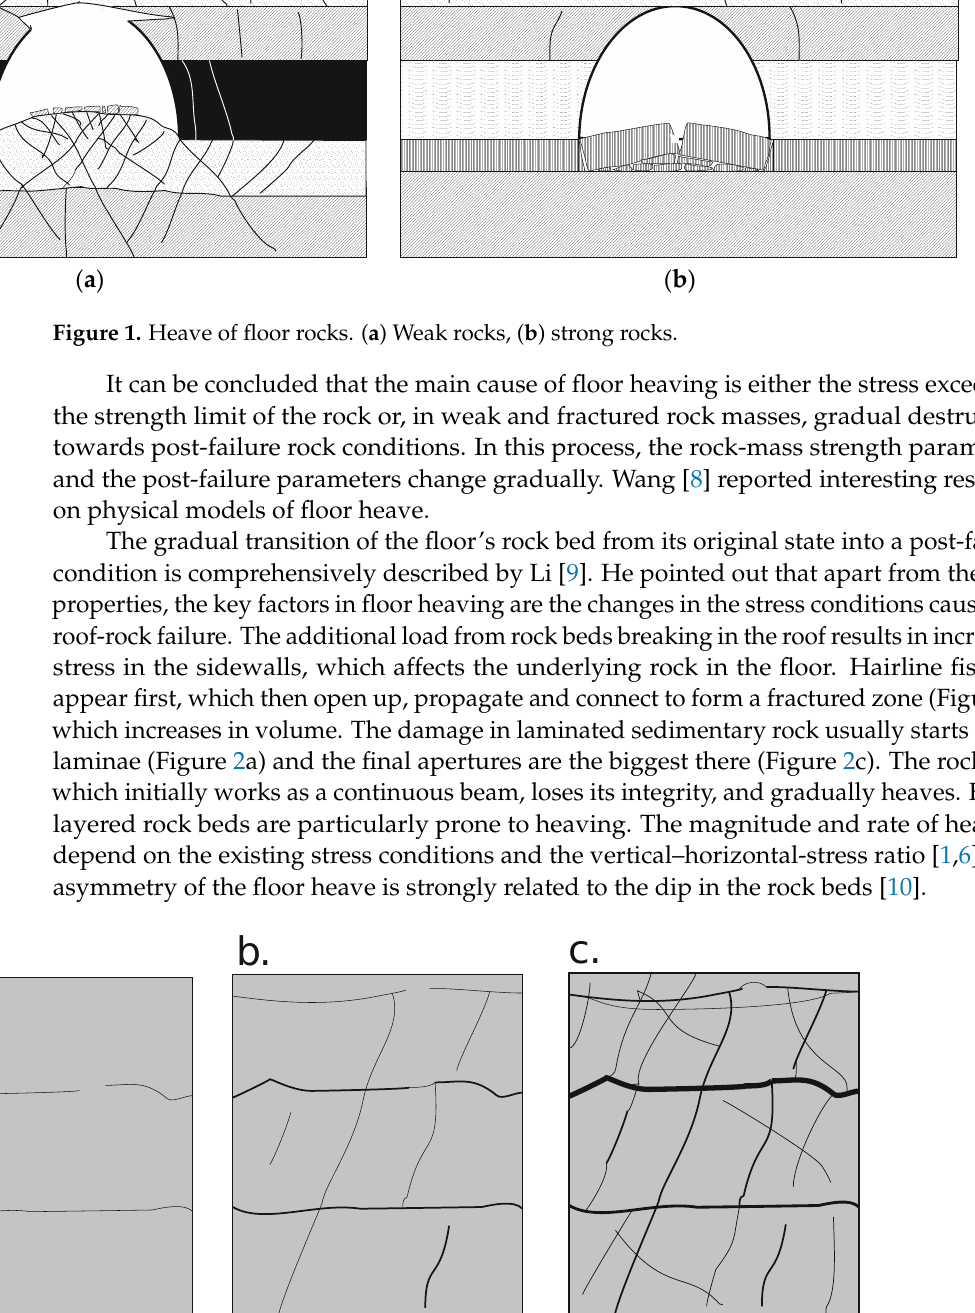
Figure 2. Propagation of fractures along with stress increase ( a ) fracture initiation, ( b ) fracture development, ( c ) fracture expansion.